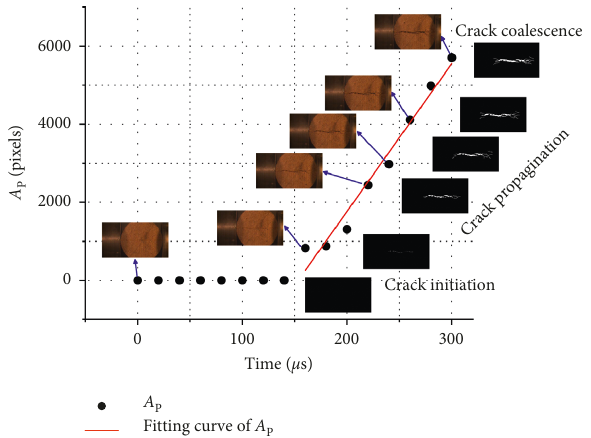
Figure 6: An illustration of crack propagation velocity compu- tation using crack area.